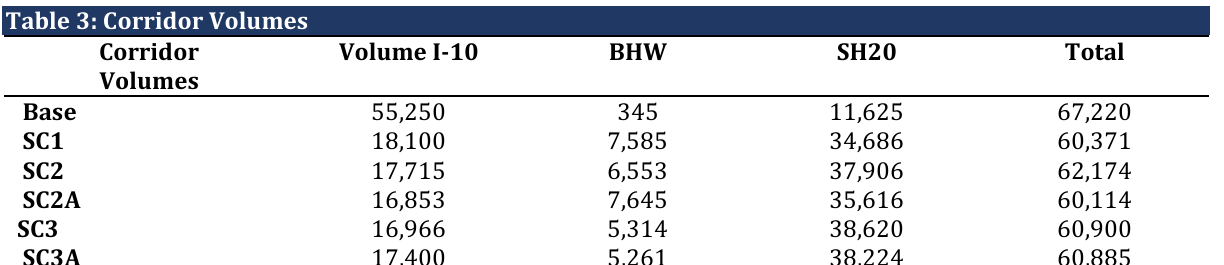
Table 3: Corridor